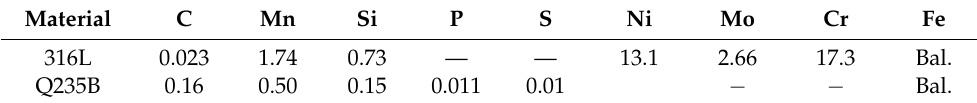
Figure 1. Tensile test sample. Table 1. Chemical constituents of 316L and Q235B (mass fraction, %).